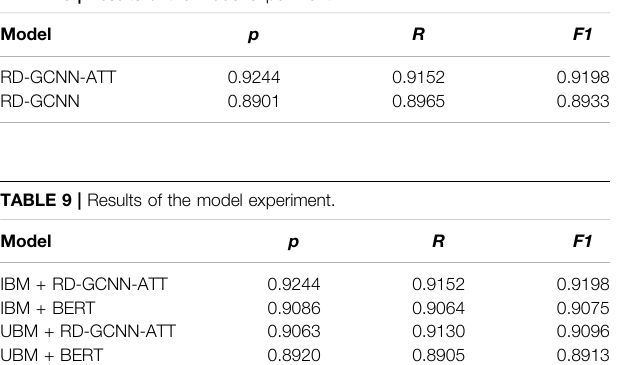
FIGURE 4 | Model training